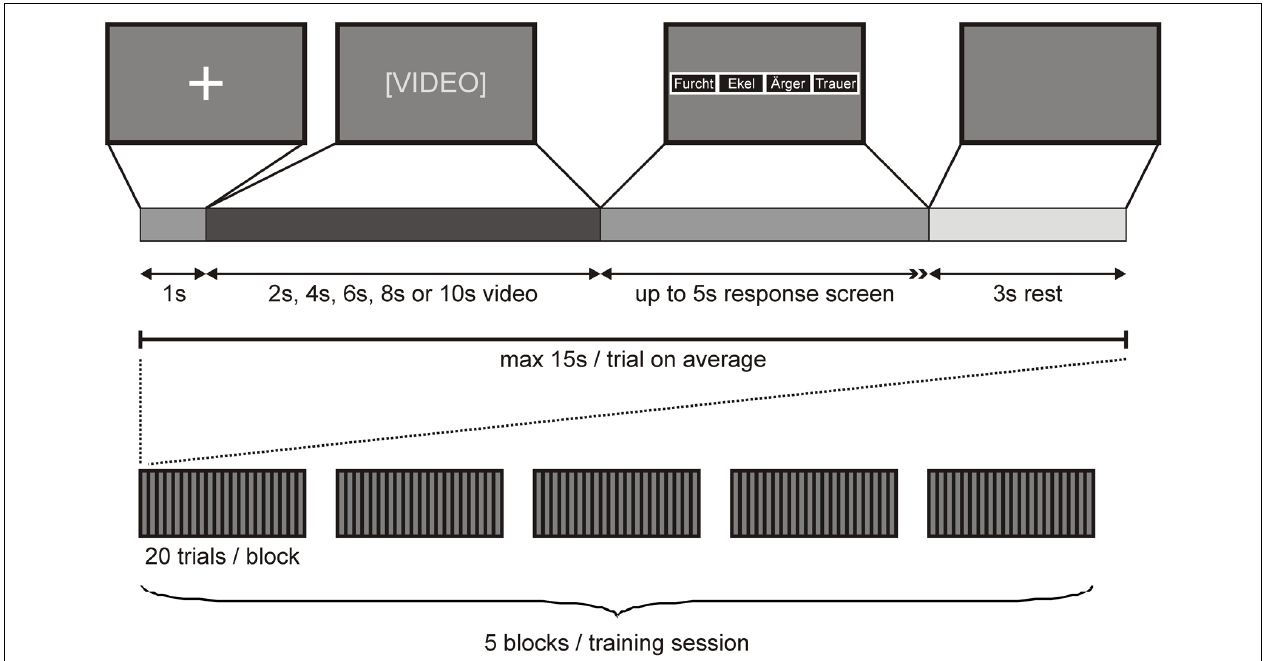
the keyboard) indicating the participant to convey her decision by button press (maximal response interval of 5 s). As soon as the participant had conveyed her response, the response screen was replaced with a dark screen for 3 s, after which the next trial began. Bottom row: A complete training session comprised five blocks of 20 trials. Each block of 20 trials contained a different subset of video